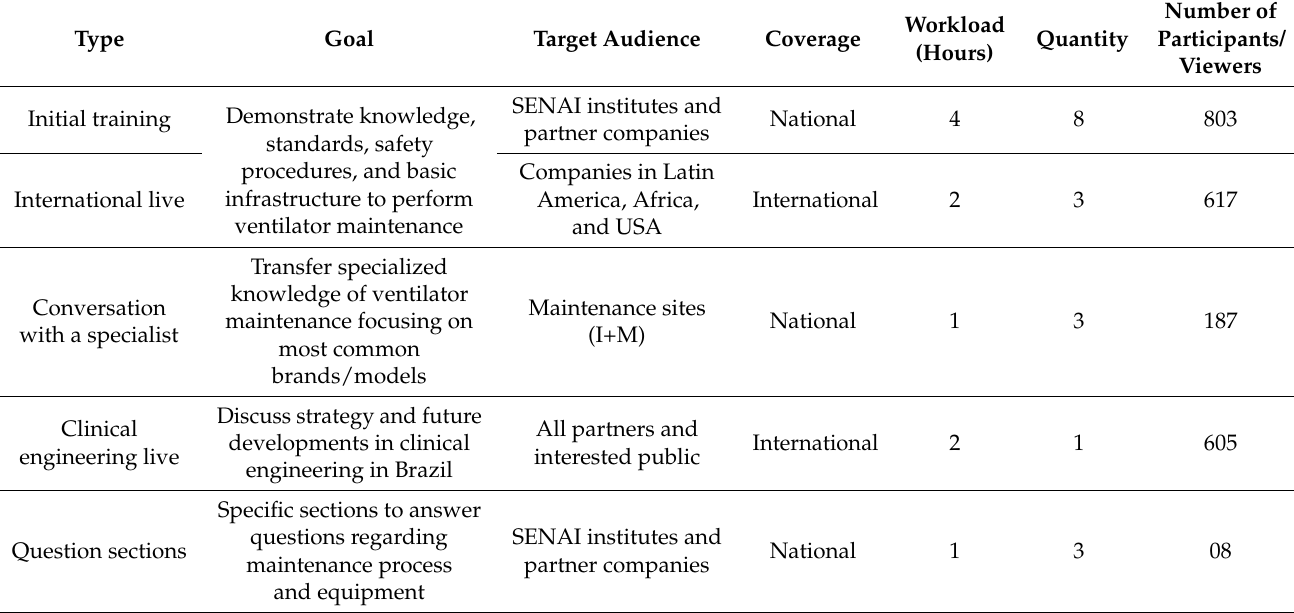
Table 2. Main training and knowledge transfer